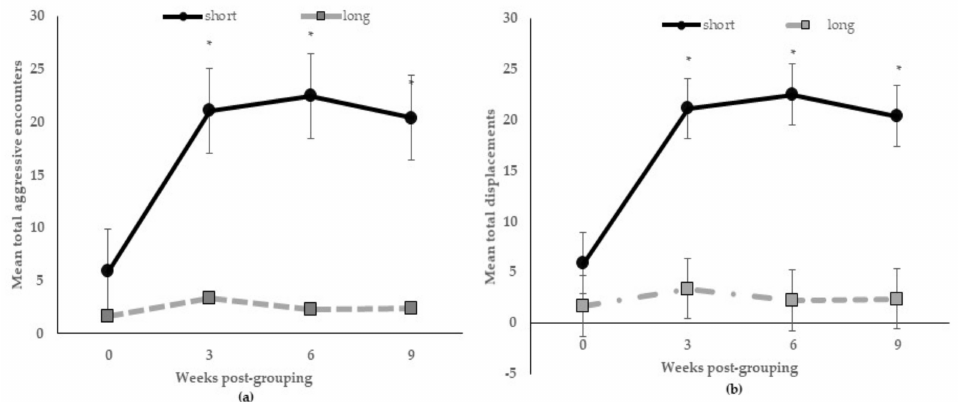
Figure 1. Mean numbers of aggressive encounters ( a ) and displacements ( b ) registered during feeding at 0, 3, 6, and 9 weeks post-grouping for sows kept in group pens with short or long feeding stall partitions. * indicates that treatment groups at those weeks post-grouping are different at p <